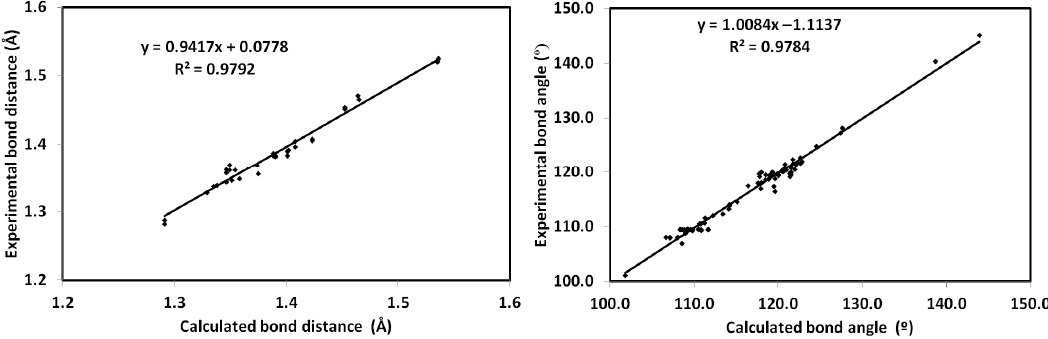
Figure 11. Correlations between the calculated and experimental geometric parameters.